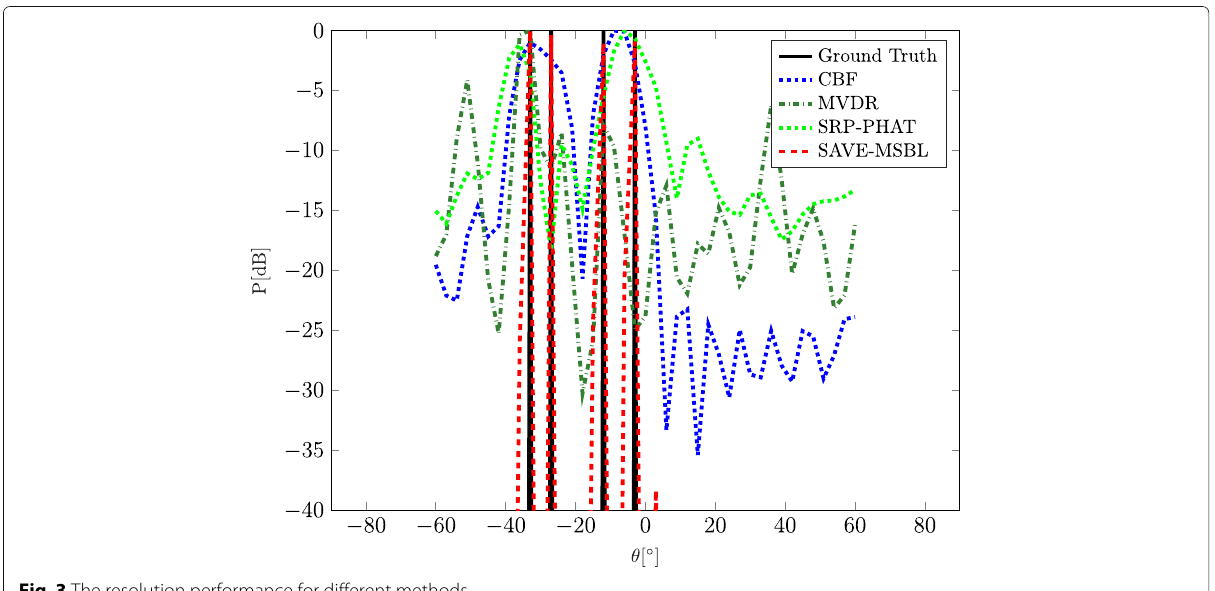
Fig. 3 The resolution performance for different methods